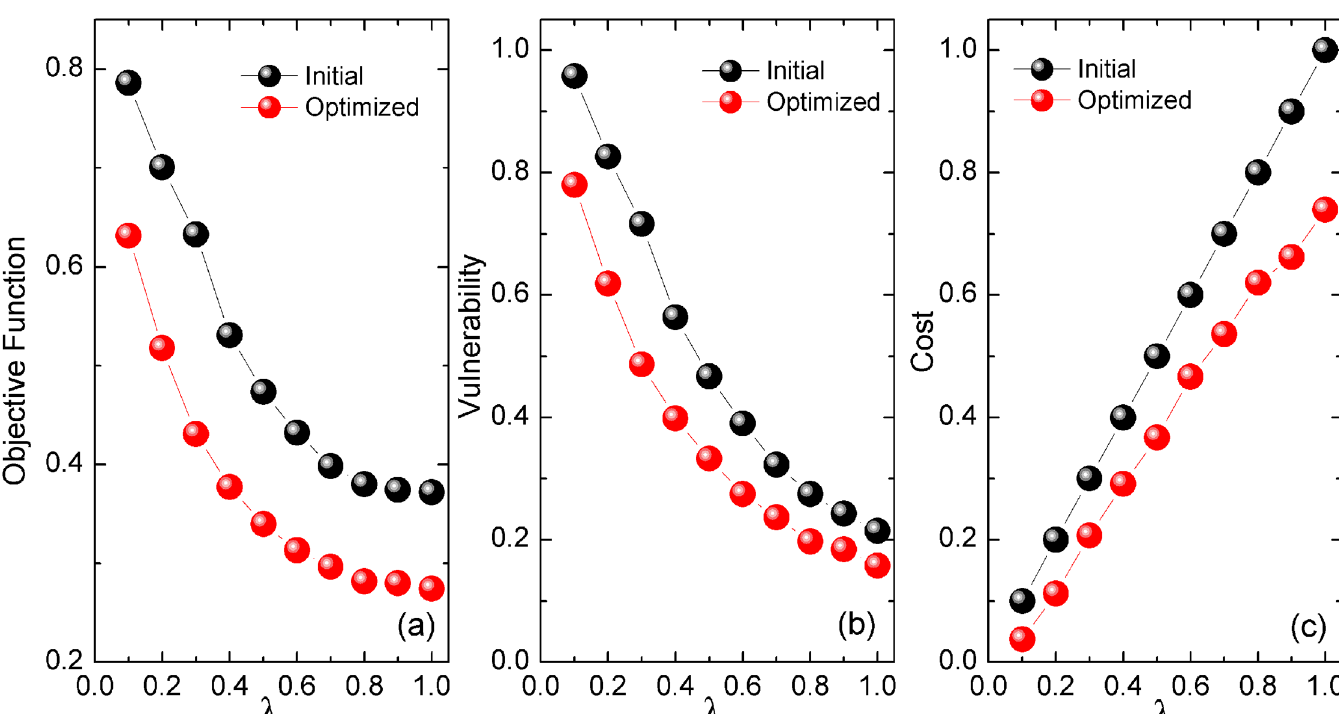
Fig 1. Performance of the optimized pattern and the initial model pattern under different maximum costs. (a) Objective function. (b) Vulnerability of the network. (c) Cost of the network. Each point is averaged from 20 different networks. The adjusting parameter is set to ω = 0.8. The algorithm runs for 1,000 iterations each